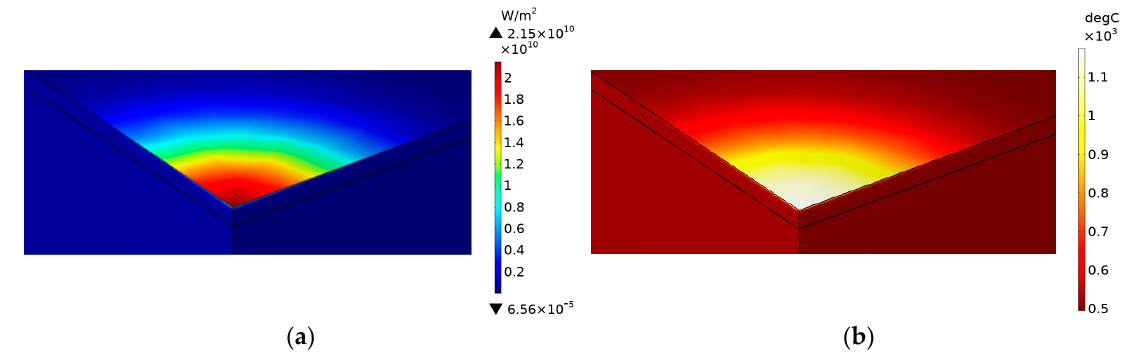
Figure 5. Changes during one pulse. ( a ) Intensity; ( b ) temperature.